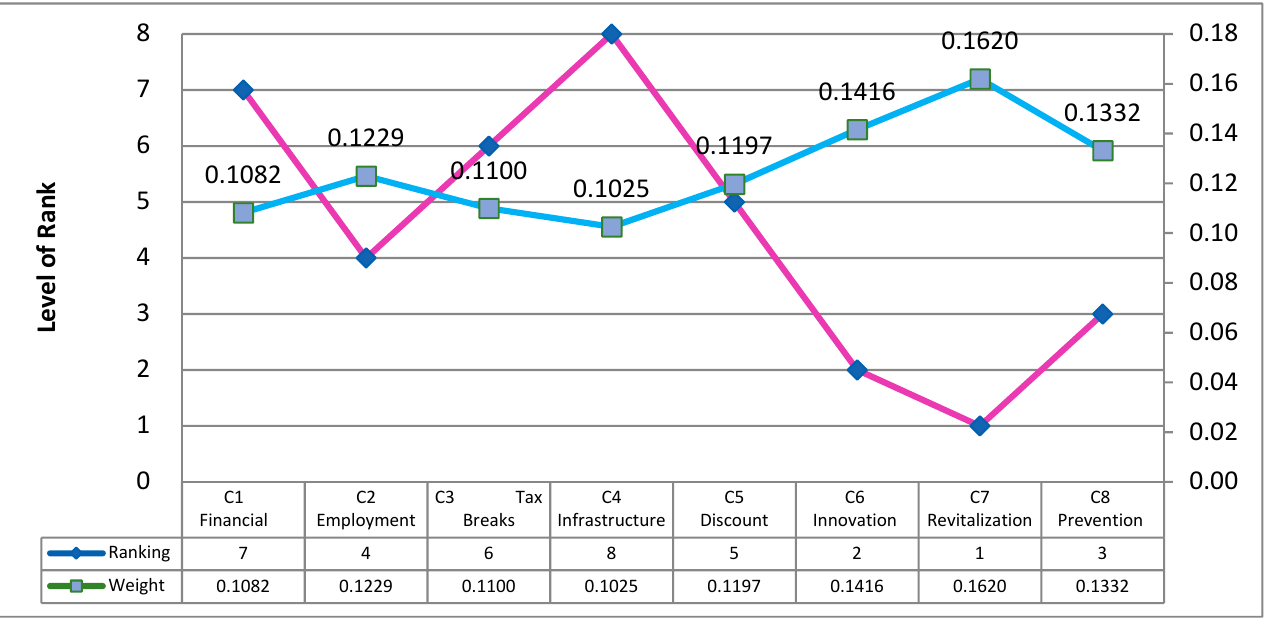
> 𝐶 > 𝐶 > 𝐶 > 𝐶 > (cid:2875) (cid:2874) (cid:2876) (cid:2870) (cid:2873)